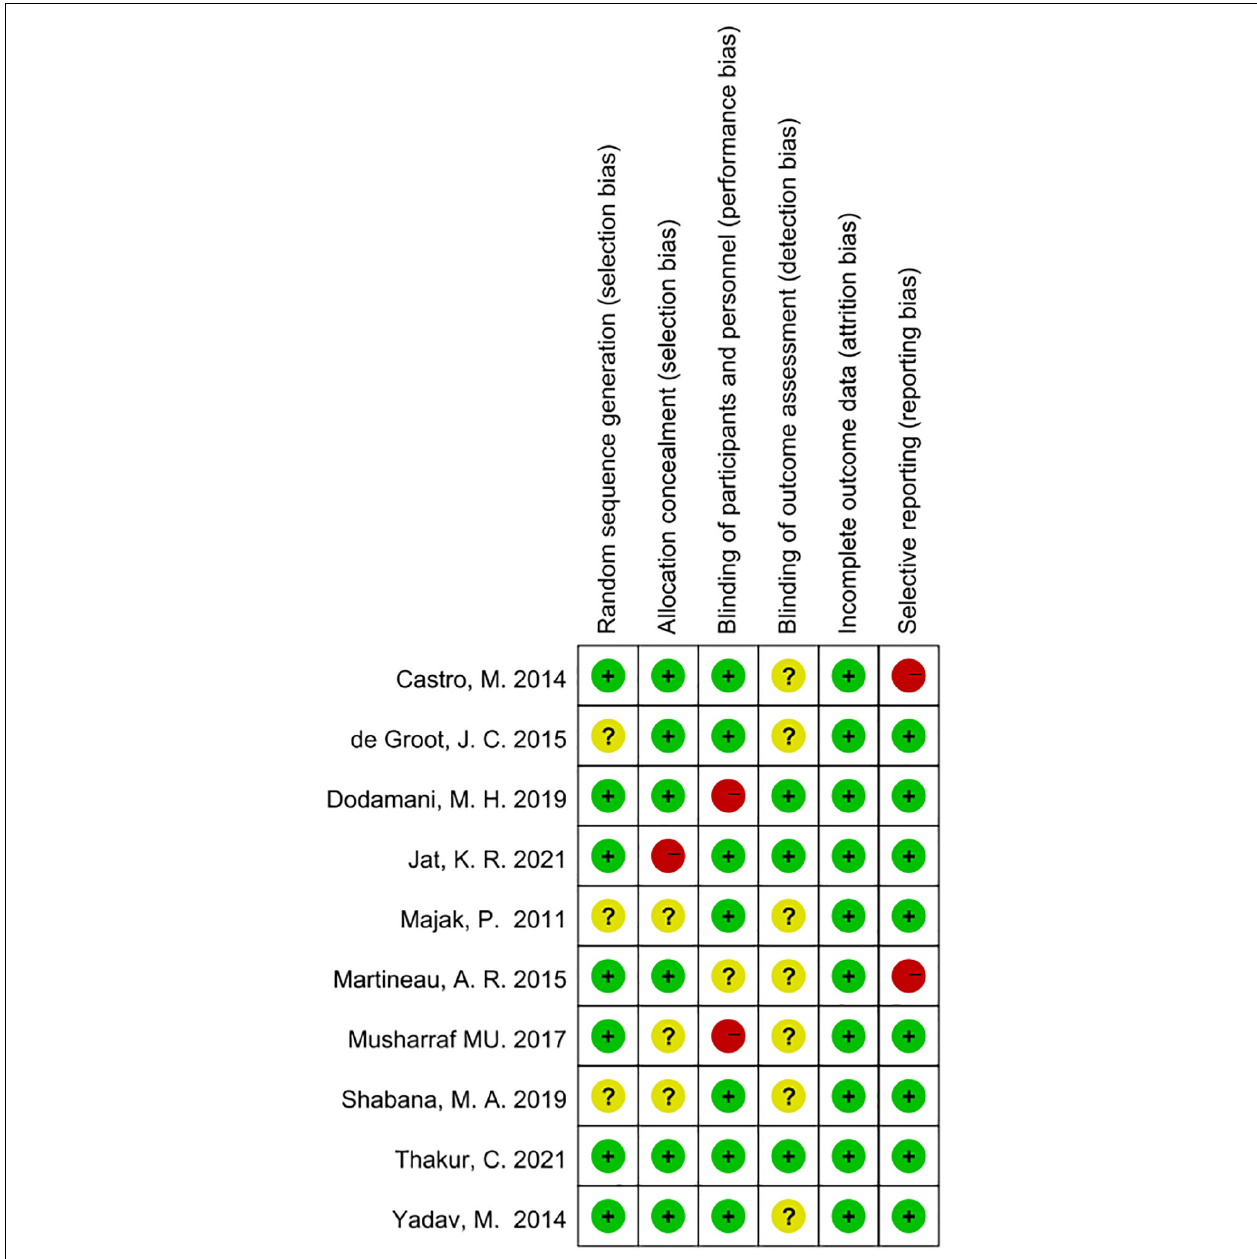
FIGURE 2 | Risk of bias summary based on Cochrane Systematic Review Guidelines for each included study included in this review (green for low risk of bias, yellow for unclear risk of bias and red for high risk of